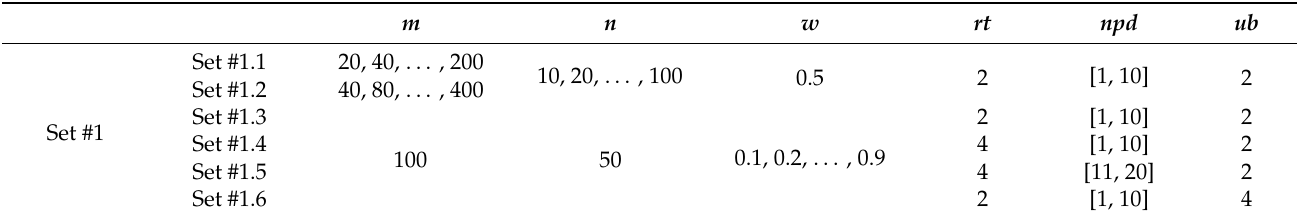
Table 5. The experimental setting of Set #1.